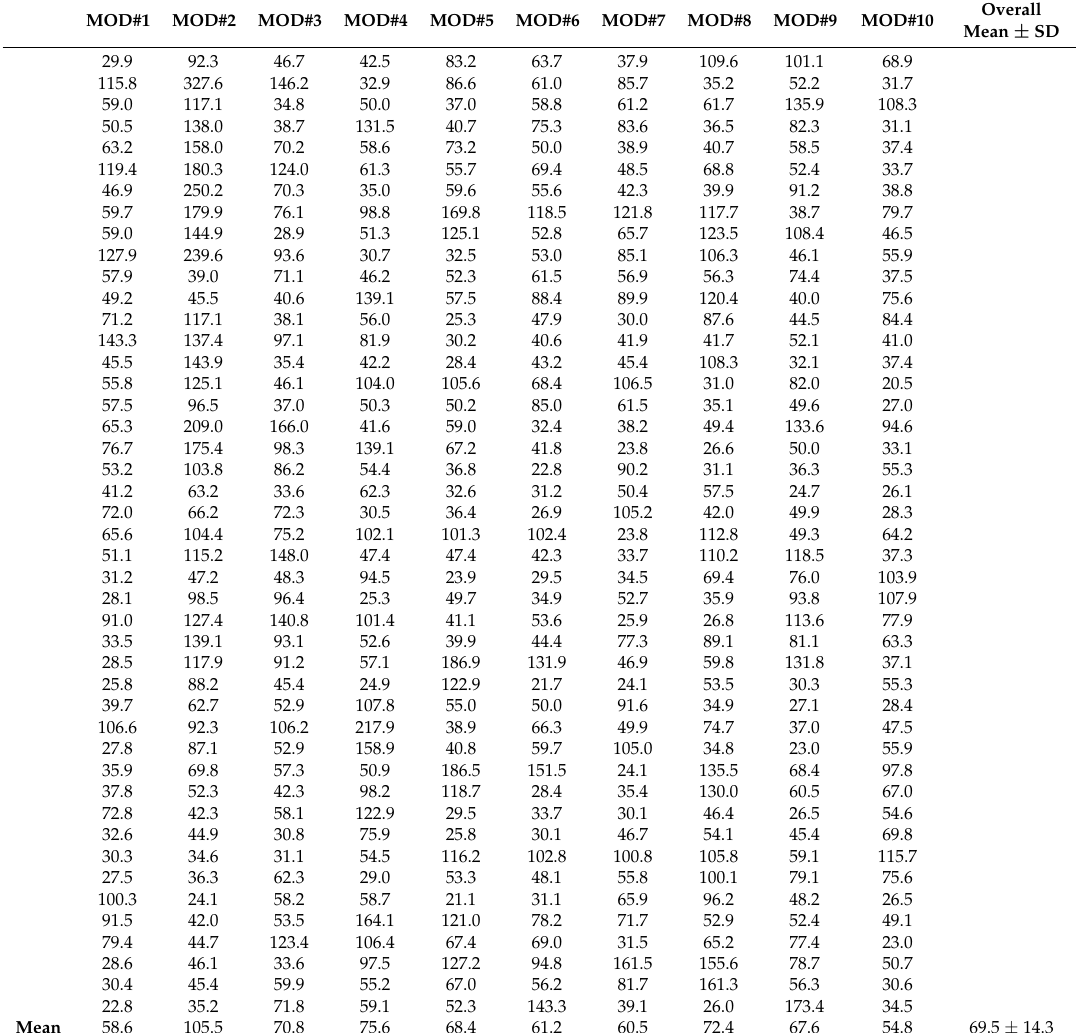
Table A2. Precision of full-arch scan performed on each maxillary typodont with an intraoral scanner (Trios 3, 3Shape, Copenhagen, Denmark) expressed in terms of the root mean square (RMS) values ( µ m). MOD, model. SD, standard deviation.